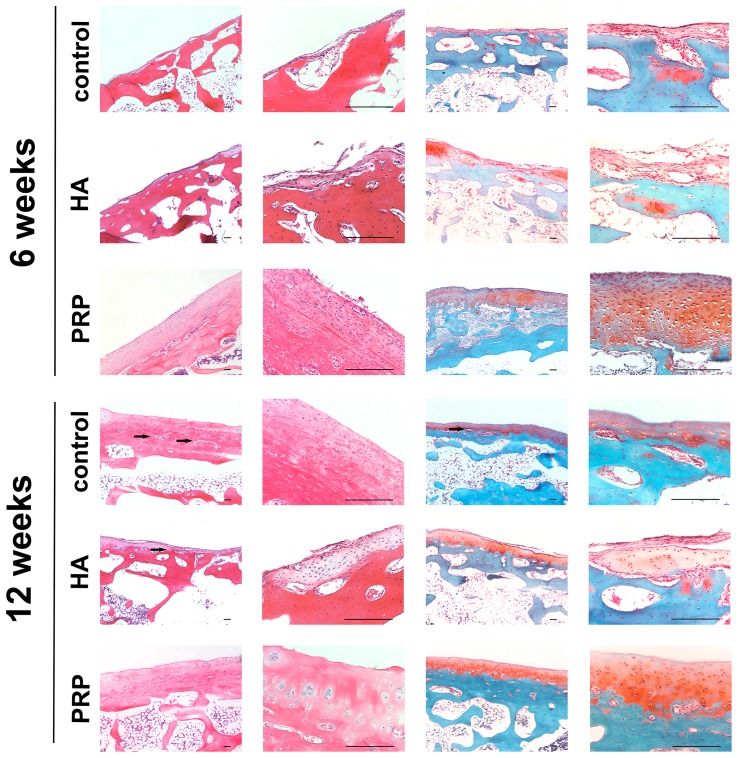
Histological assessment of cartilage restoring effects of the three groups.The left two columns were H&E stained and the right two columns with Safranin-O. For each staining, the images of the right column are magnified from the left column. The capillary infiltration areas were indicated with black arrows. All scale bars represent 200 µm.